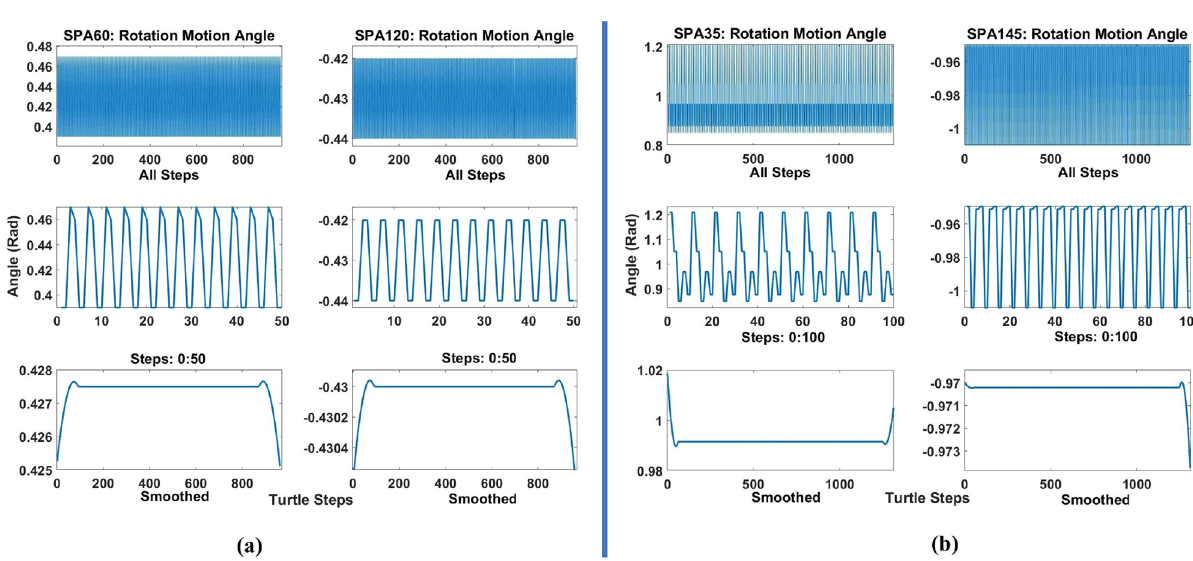
Figure 8. ( a ) SPA35, and SPA145 rotation motion angle hysteresis input for turtle movement, ( b ) SPA60, and SPA120 rotation motion angle hysteresis input for turtle